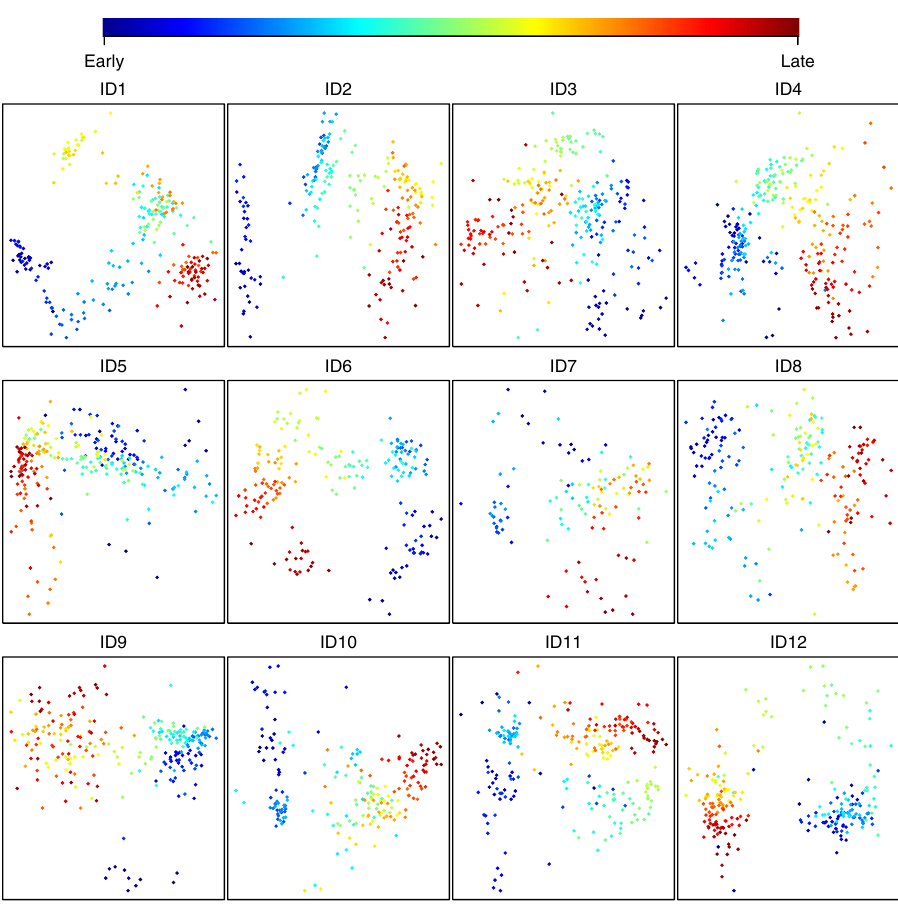
Fig. 1 Development of the infant GI microbiota is highly structured in time. Each panel shows a non-metric multidimensional scaling (nMDS) plot based on Bray – Curtis distances, for each of the 12 infants. For each model there is a highly signi fi cant relationship between the primary axis of variation and time since birth (for all tests p ≪ 0.001, mean R 2 = 0.7 (range 0.47 – 0.86), linear regression). Dots are colored according to the bar above the panels. Early and late refer to the order in which the samples were collected (see Table 1 for days of fi rst and last